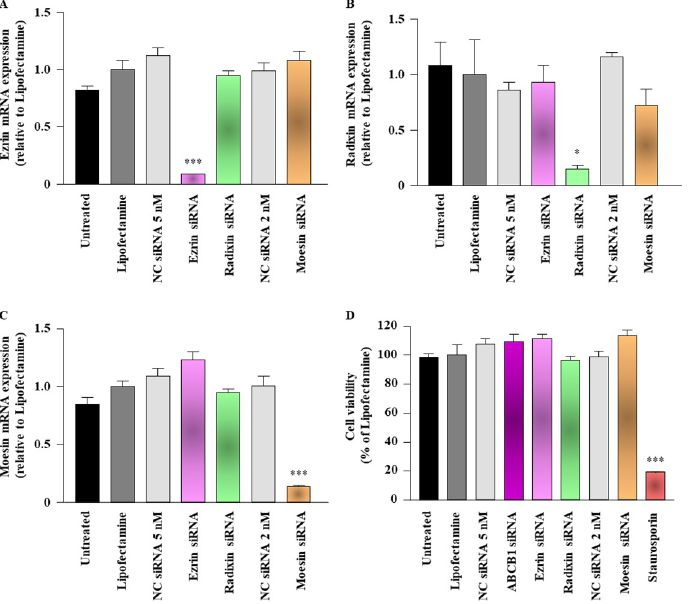
Fig 2. Effect of siRNAs targeting ezrin, radixin, or moesin on the mRNA expression of ezrin, radixin, and moesin (ERM) in LS180 cells. Cells were treated with the transfection medium (Untreated), transfection reagent (Lipofectamine), nontargeting control (NC) siRNA, and specific siRNAs for ezrin, radixin, or moesin and then incubated for 3 days. (A–C) Expression of each mRNA in the cells treated with siRNAs relative to that in cells treated with the transfection reagent alone was measured by real-time quantitative reverse transcription-polymerase chain reaction. n = 3, ��� p < 0.001, � p < 0.05 vs. Lipofectamine. (D) Cell viability was assessed with the PrestoBlue cell viability reagent. Staurosporine was used as a positive control for inducing cell death. n = 4, ��� p < 0.001 vs. Lipofectamine. All data are expressed as the mean ± SEM and were analyzed by one-way ANOVA followed by Tukey’s